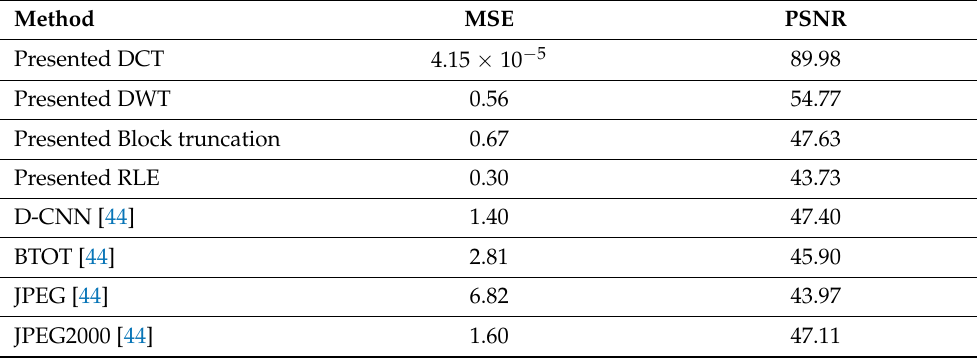
Table 2. The comparison between the presented methods and the